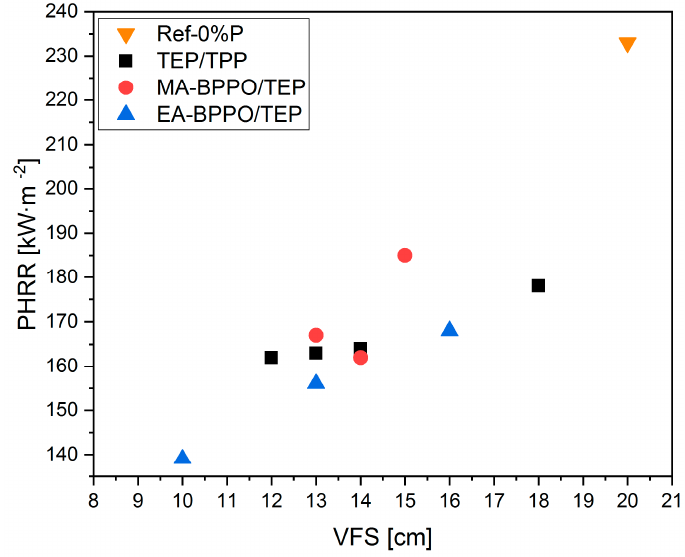
Figure9. CorrelationbetweenPHRRandVFSofthereferencefoams, MA-BPPO / TEP,andEA-BPPO / Figure 9. Correlation between PHRR and VFS of the reference foams, MA-BPPO/TEP, and EA-BPPO/TEP.